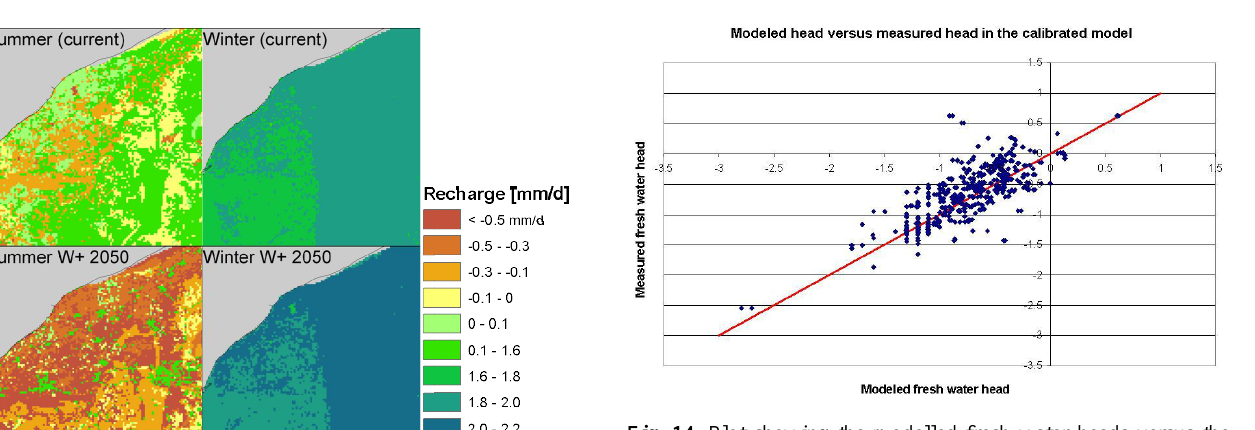
Figure 14 Plot showing the modelled fresh water heads versus the measured fresh water heads.